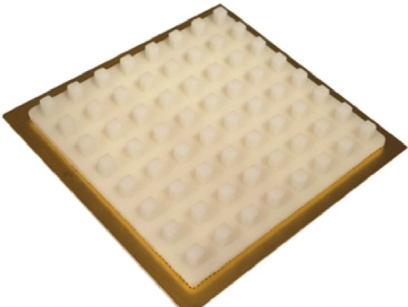
Figure 9: Top view of the 8 × 8 DRA array proposed in